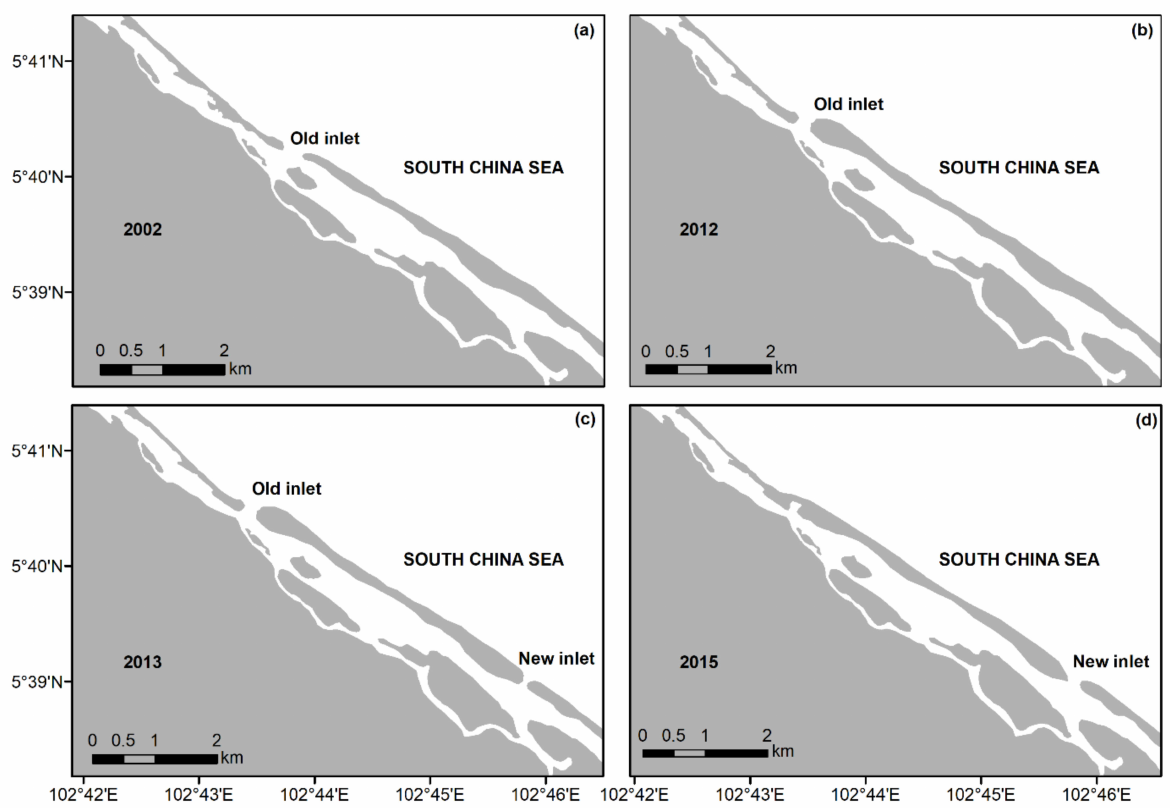
Figure 1. The shoreline changes in Setiu Lagoon during ( a ) 2002, ( b ) 2012, ( c ) 2013, and ( d ) 2015, digitized from Google